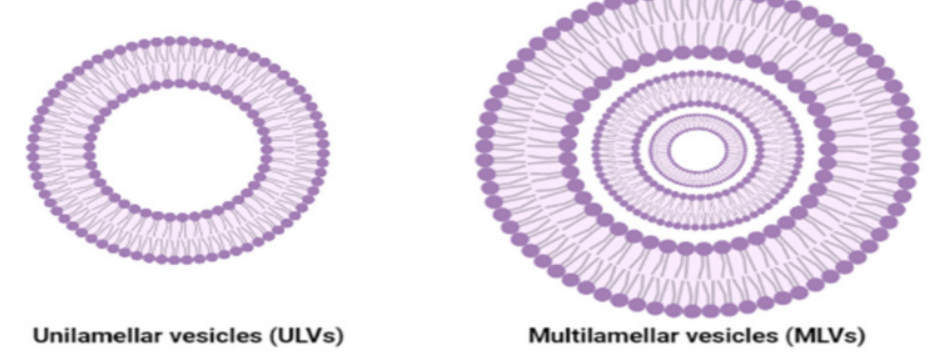
Figure 11. Structural representation of unilamellar and multilamellar vesicles. Created with BioRender.com (accessed on 10 January 2022).